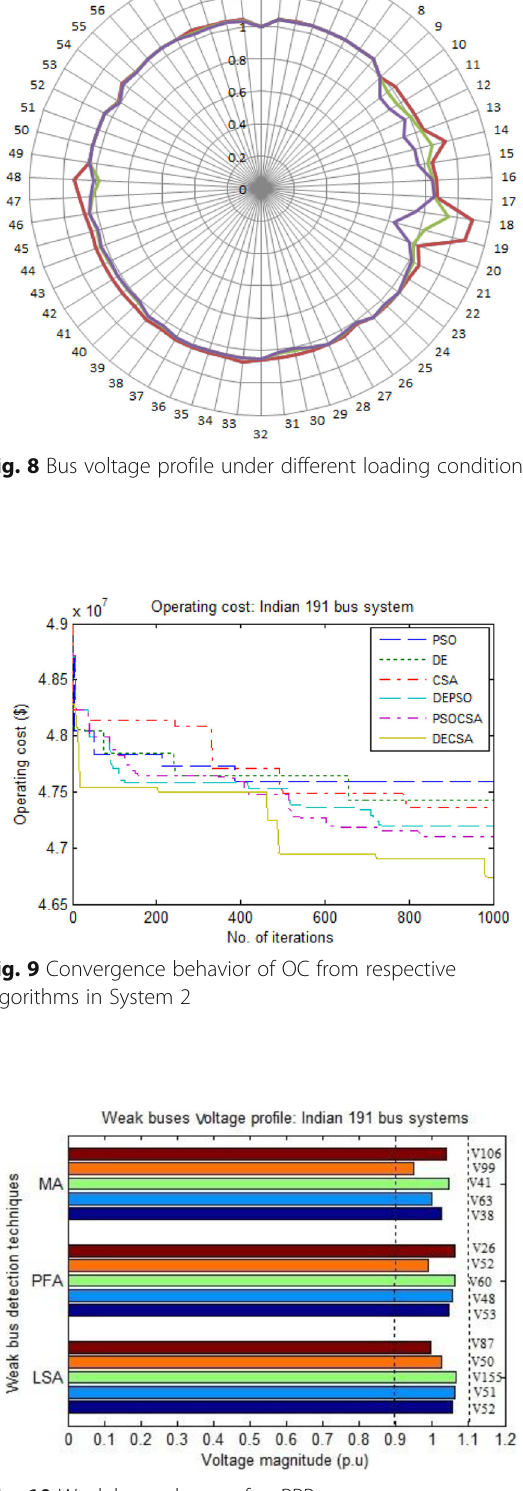
Fig. 7 Weak bus voltages after RPP Fig. 10 Weak bus voltages after RPP